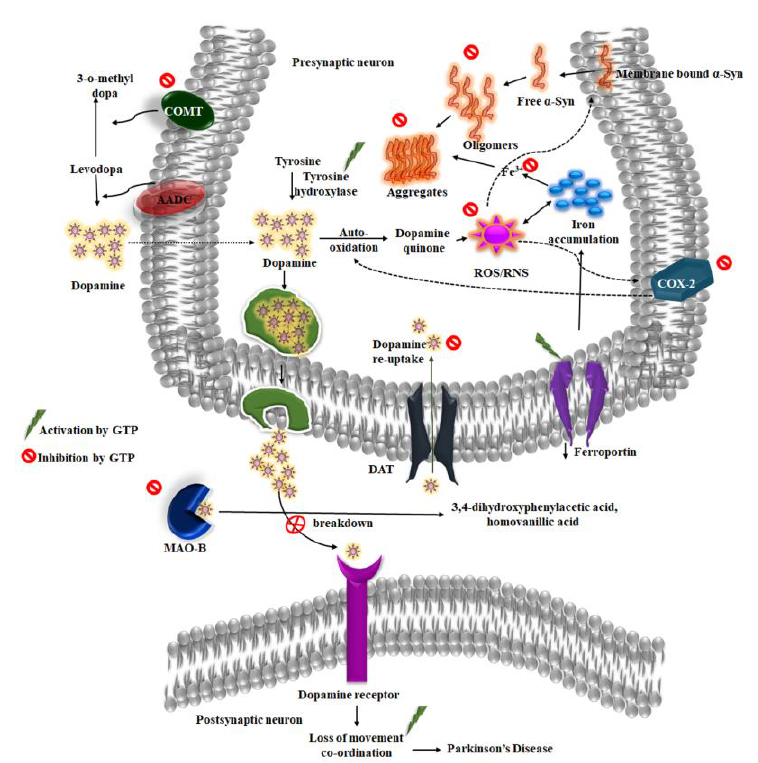
Figure 2. Neuroprotective action of green tea polyphenols (GTP’s) in prevention of the pathological process occurring during Parkinson’s disease. GTP can possibly act as inhibitors of α-synuclein aggregation, MAO-B, COMT, prevent the accumulation of iron and activate TH to protect dopaminergic neurons degeneration.